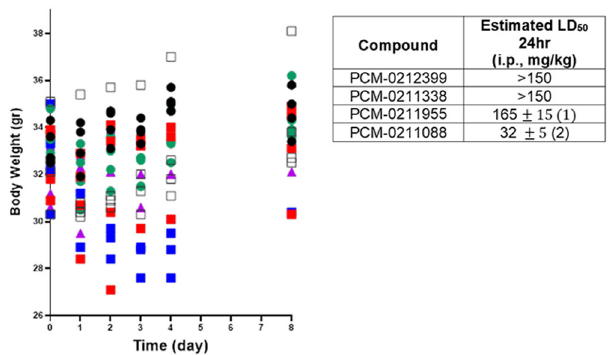
Fig. 3 Time-course of change in daily body weight of mice and acute toxicity of oximes. Time-course of change in daily body weight of mice and acute toxicity LD 50 values. Mice were injected with oximes at speci fi ed doses (i.p., n = 4). PCM-0211338 (green circle), PCM-0212399 (red square) and PCM-0211955 (blue squares) were administered at 150 mg/kg i.p. PCM-0211088 (purple triangles) was administered at 25 mg/kg i.p. DMSO (black open squares) was administered at 0.1 ml i.p. as solvent control. Sham animals (black circles) were not treated. Ordinary one-way ANOVA comparing body weights of oxime-treated mice to DMSO control (black open squares) display a signi fi cant difference for PCM-0211955 treated mice (blue squares) ( p < 0.001). Data are provided in Supplementary Data fi le 1. (1) At a dose of 150 mg/kg ( n = 4) mild toxic signs of PCM-0211955 were observed within 4 – 6 h post-injection. After 24 h one out of four animals died. At day 5 two more animals died. The curve of daily weight change of surviving animals indicated early toxic signs on day 1. (2) The LD 50 of PCM-0211088 (24 h) and PCM-0211955 (48 h) was determined by the up and down method (see “ Methods ”